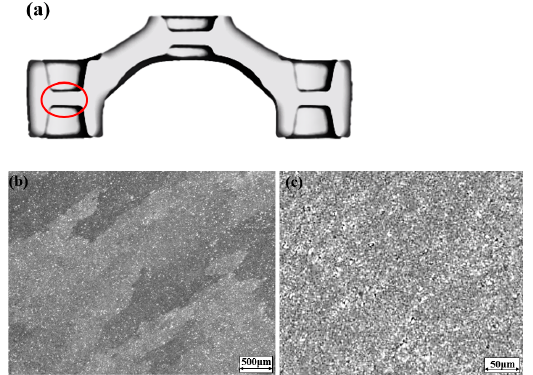
Figure 13. Microstructure of AA6066-T6 workpiece (true strain = 1). ( a ) Experimental observation position on the workpiece; ( b ) microstructure image of crown forgings (500 μ m); ( c ) microstructure image of crown forgings (50 μ m).